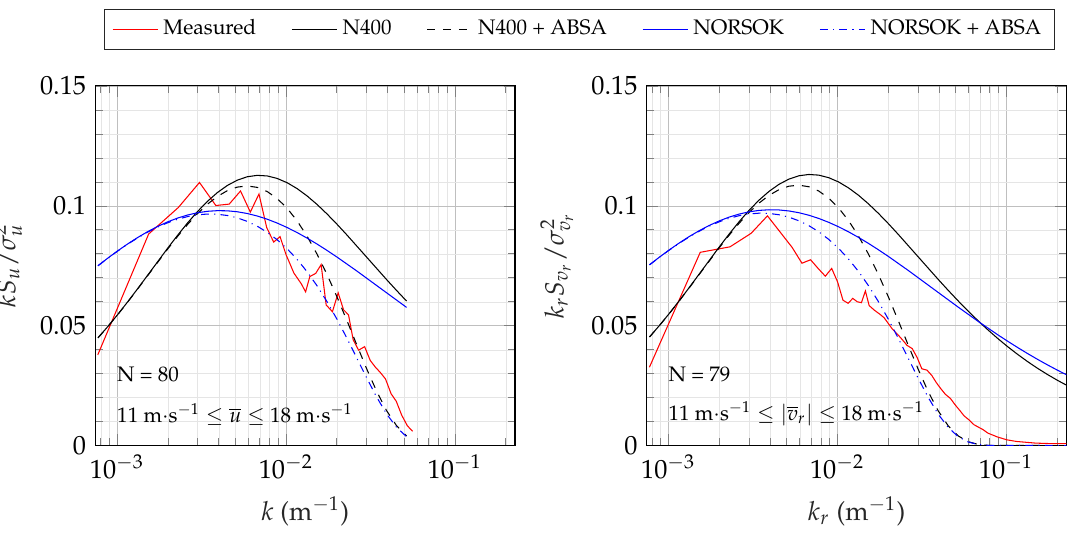
Figure 9. Normalized wind spectrum recorded using both data recorded by LW2 and LE from the 07-06-2016 to 22-06-2016 ( left panel ) and LE alone ( right panel ) for the N-S configuration. When the high-frequency range of the N400 wind spectrum is attenuated using the ABSA model presented in Equation (26), the slope of the high-frequency part of the modified spectrum is sharper than measured, as seen in Figure